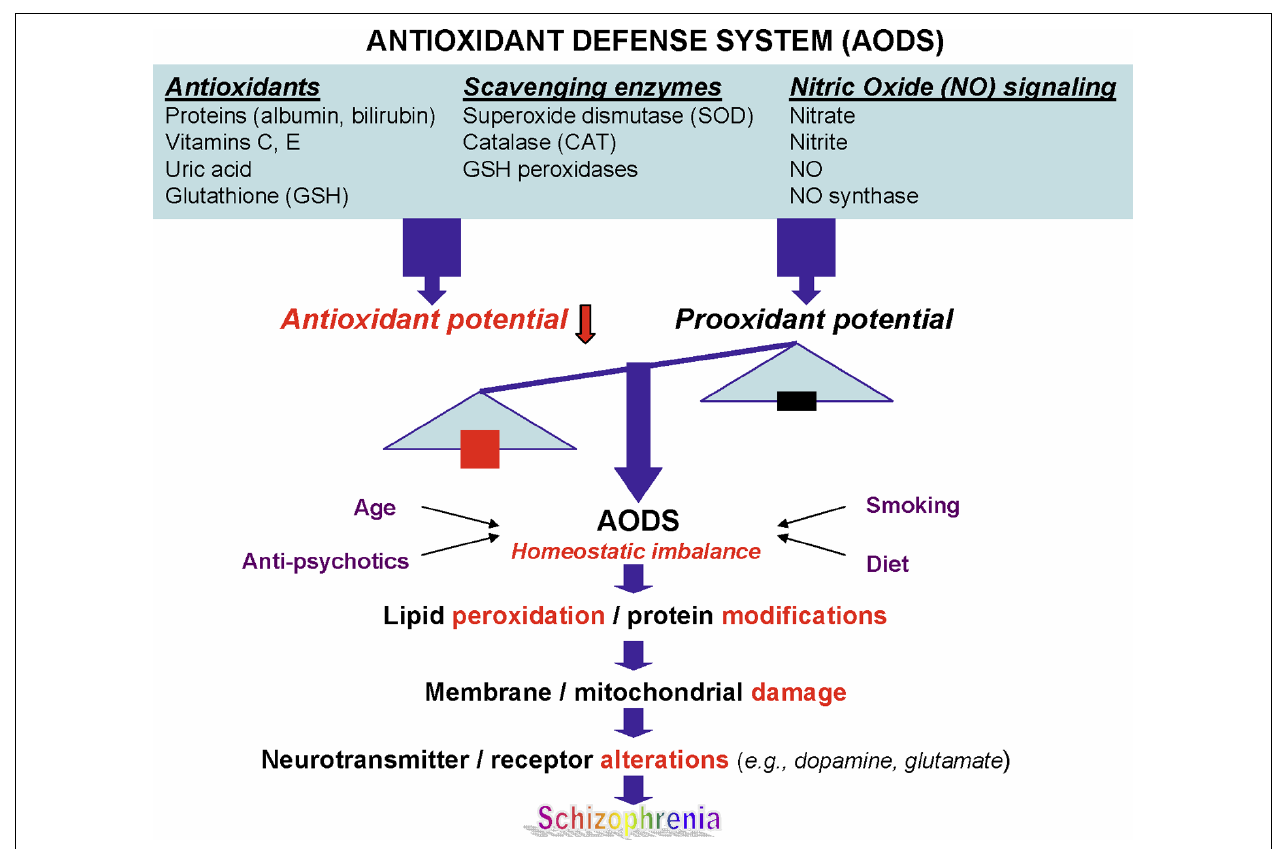
FIGURE 1 |A schematic diagram linking antioxidant defense system, membrane phospholipids, and neurotransmission to pathophysiology in schizophrenia. Reprinted by permission fromYao and Keshavan